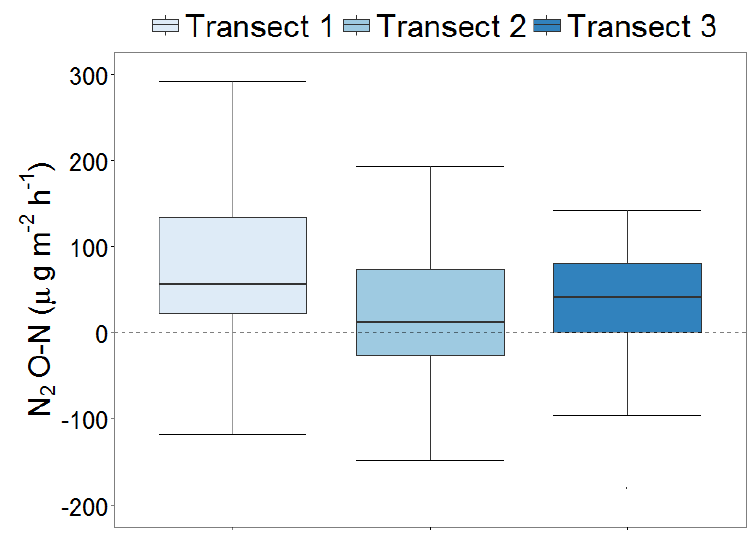
Figure 5. Nitrous oxide emissions from plots along the slope catena of three transects based on combined data from all campaigns.